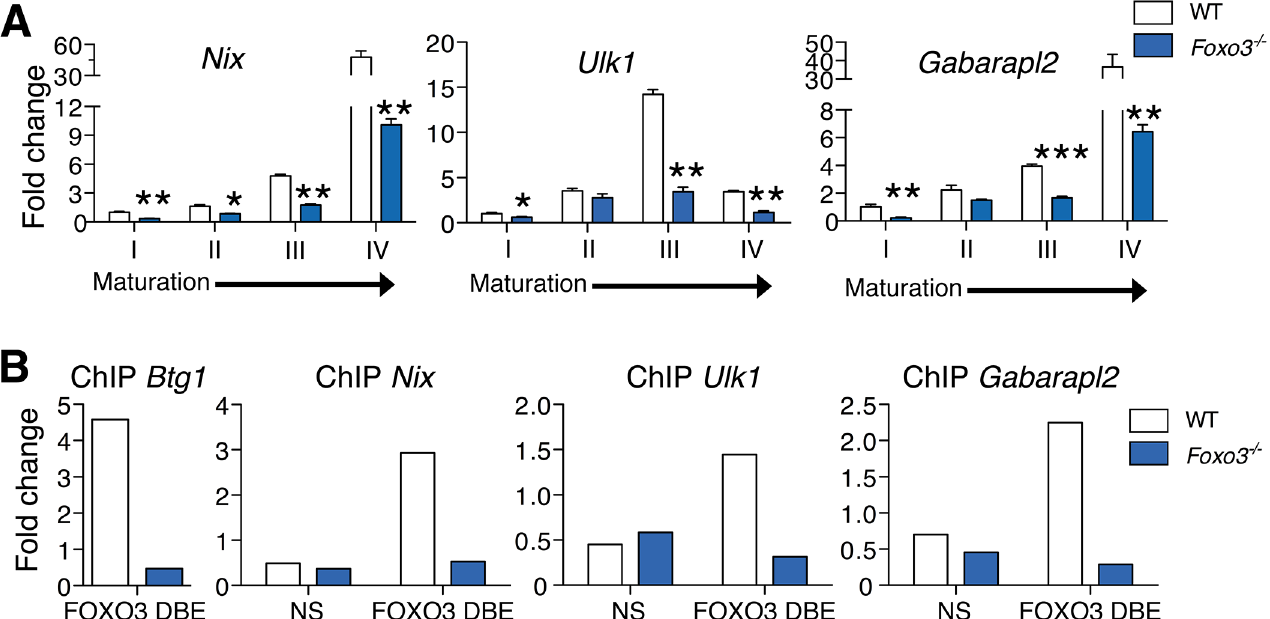
Fig 2. FOXO3 regulates expression of autophagy and mitochondrial removal related genes in erythroblasts. (A) Fluidigm microfluidic qRT-PCR expression analysis of autophagy genes in WT and Foxo3 -/- Gates I to IV bone marrow erythroblasts. Quantification of target genes is relative to β actin. Results are mean ± SEM of 3 cDNAs, each generated from one mouse. * P < 0.05 ** P < 0.01 *** P < 0.001, Student ’ s t test. (B) FOXO3 binding to Btg1, Nix, Ulk1 and Gabarapl2 regulatory regions as determined by ChIP in total TER119 + cells. Enrichment of putative FOXO3 DNA binding regions in Btg1 (positive control), Nix, Ulk1 and Gabarapl2 promoters was analyzed by qPCR and compared to regions with no known FOXO3 binding sites in wild type versus Foxo3 -/- erythroid cells used as negative controls. Values were normalized to Ct values from total input. One representative of two experiments is shown. NS Not specific; DBE DNA binding element.